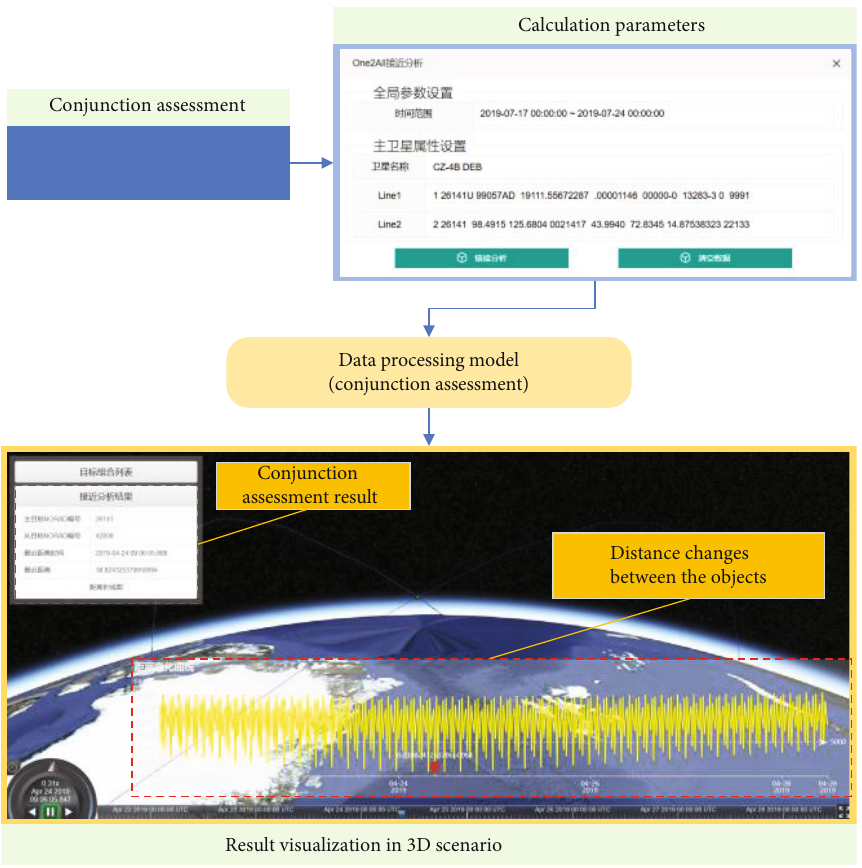
Figure 17: Execution fl ow and visualization of the conjunction assessment. In the scenario, by selecting di ff erent object combinations, the conjunction assessment results (the NORAD catalog number of objects, the minimum distance, and the closest time) and the change of distance between the objects can be displayed in a di ff erent